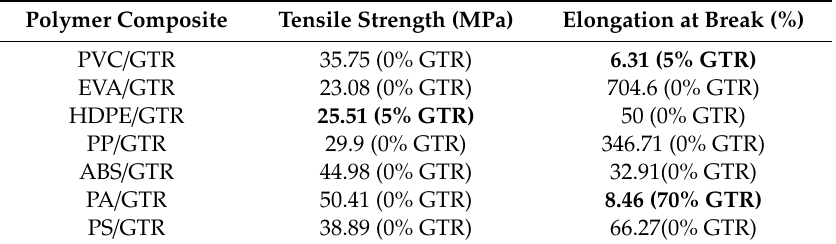
Table 3. Analysis of the highest mechanical property values of each property, and the composites regarded (size particle of GTR < 200 µ m).